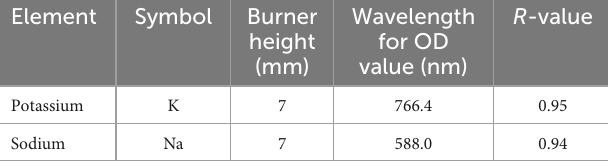
TABLE 2 Details of autosampler atomic absorption spectrophotometer parameters. Element